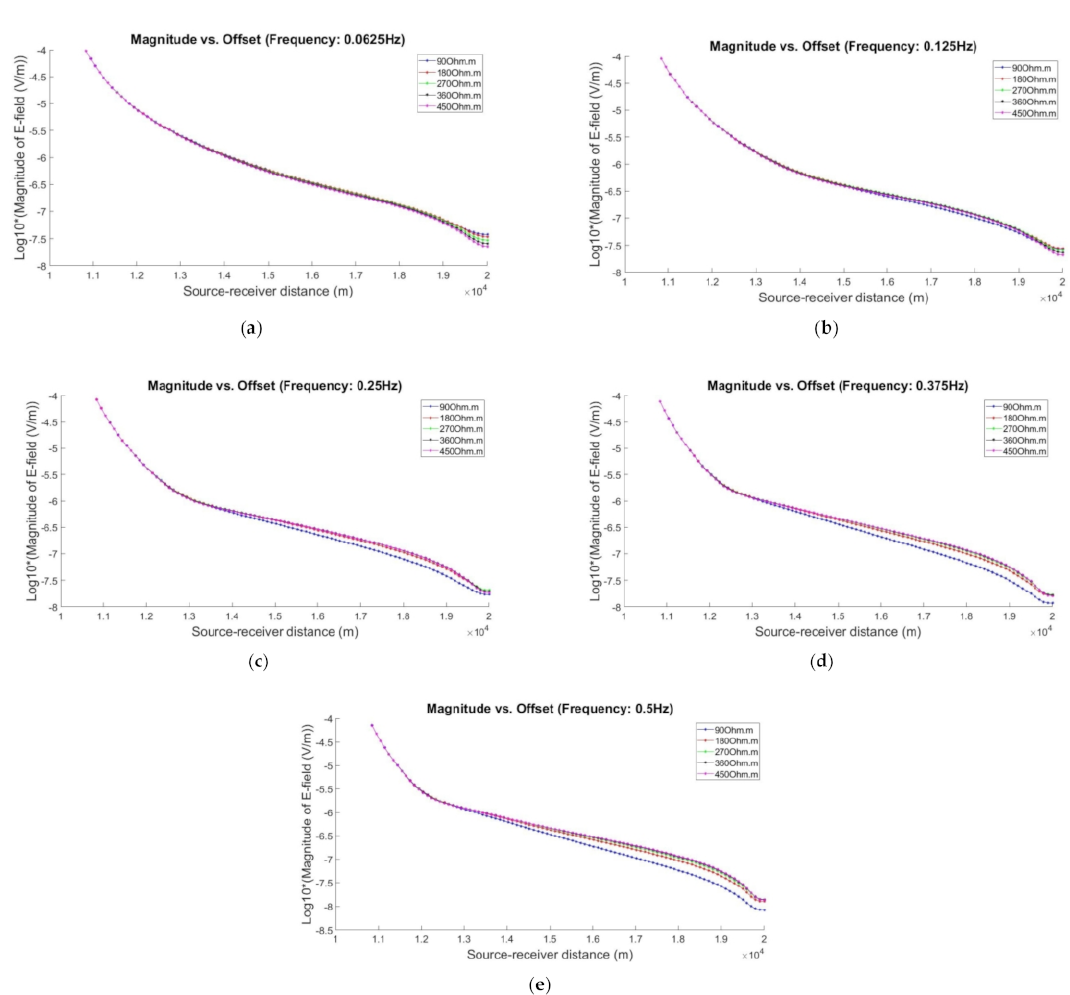
Figure 3. Magnitude of electric field (E-field) versus offset for five different hydrocarbon resistivities (90, 180, 270, 360, and 450 Ω m) for five different transmission frequencies: ( a ) 0.0625 Hz, ( b ) 0.125 Hz, ( c ) 0.25 Hz, ( d ) 0.375 Hz, and ( e ) 0.5 Hz.